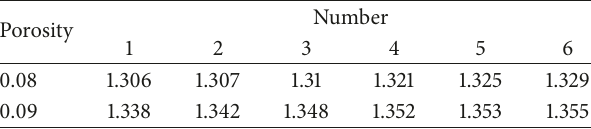
Table 2: The porosity and fractal dimension of the RVEs. Porosity